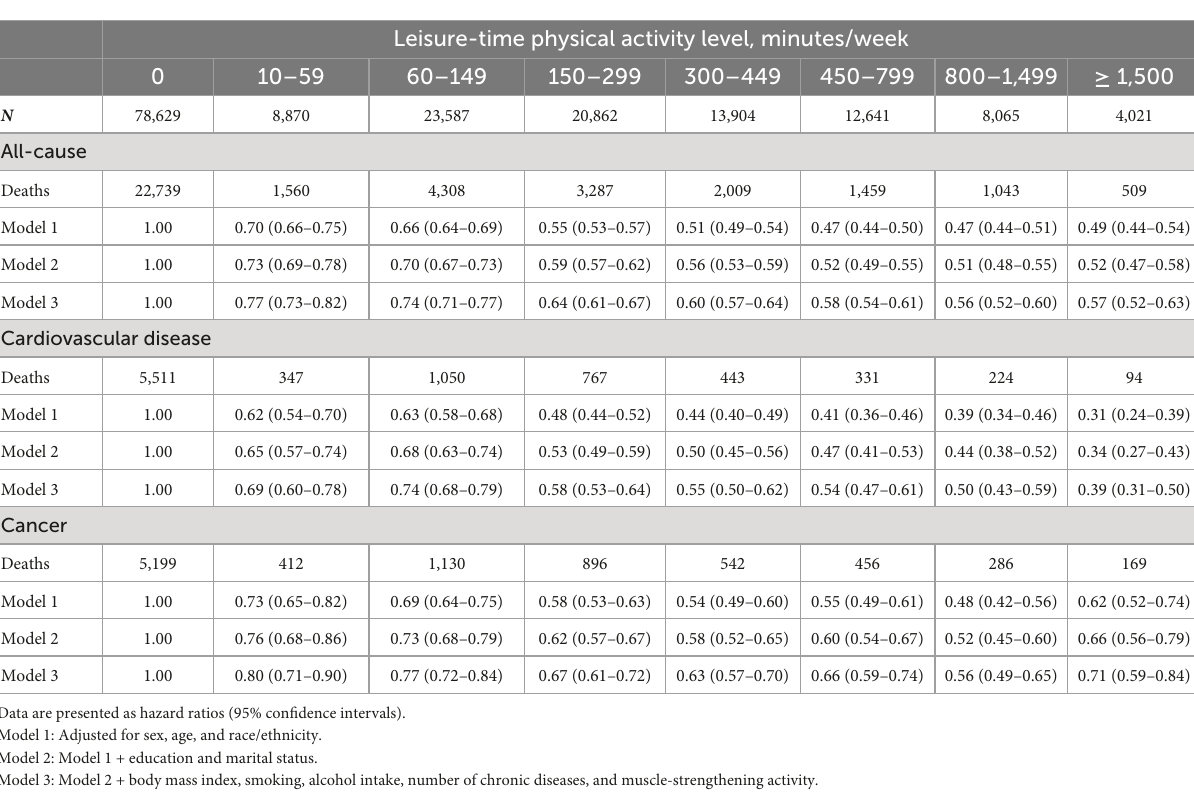
TABLE 2 Association between total leisure-time physical activity level and all-cause and cause-specific mortality.